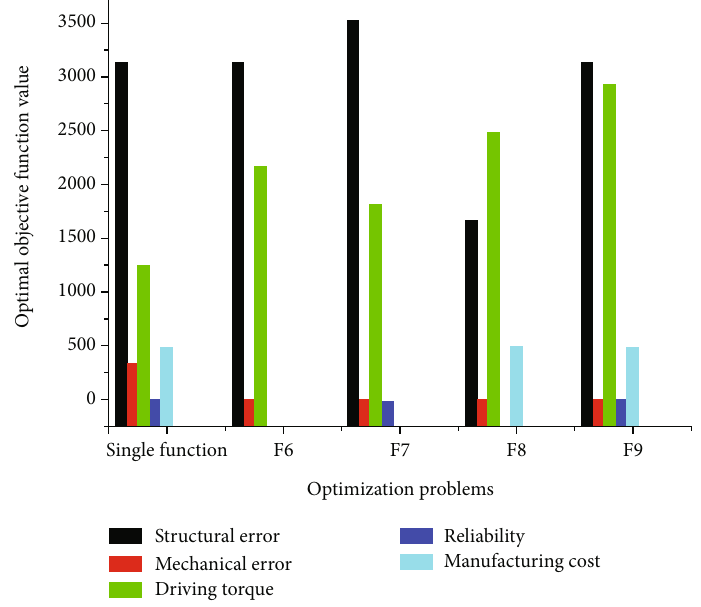
Figure 6: Behavior of each objective function versus optimization Figure 5 is plotted based on the partial data from Table 4.